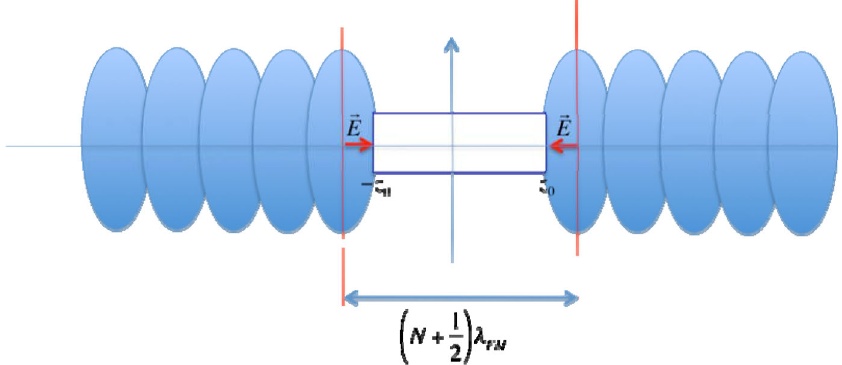
FIG. 3. (Color) Placing two cavities about ð 2 N þ 1 Þ (cid:1) FM = 2 apart, where N is an integer, provides their natural phasing of 180 degrees apart, and the opposite sign of the electric field in their end cells.